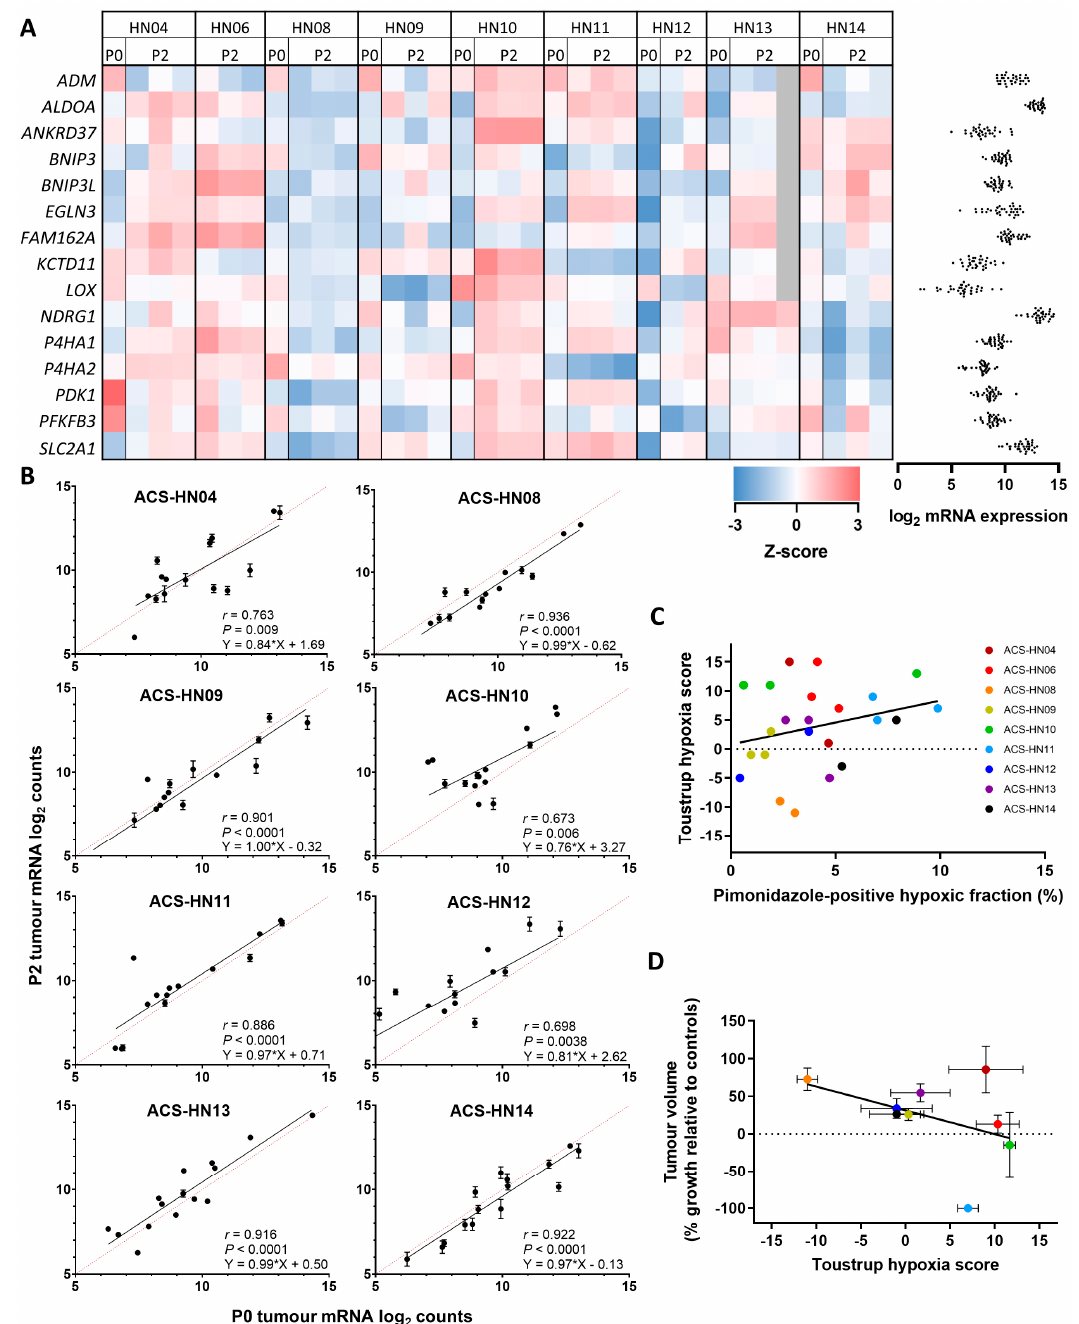
Figure 4. Hypoxia status of HNSCC PDX tumours by Toustrup hypoxia gene signature analysed by NanoString. ( A ) Heatmap of mRNA expression of 15 Toustrup signature genes in P0 and P2 PDX tumours determined as z-score relative to other PDX tumour samples. Red indicates high expression, blue indicates low expression, grey indicates not determined. Gene expression determined as log 2 counts normalised to positive control and three housekeeping genes. Individual counts shown on the right. ( B ) Comparison of mRNA expression of 15 Toustrup genes in P0 ( n = 1) and P2 ( n = 2–3) PDX tumours. Symbols represent mean ± SEM. Dotted lines represent equal expression. ( C ) Comparison of hypoxic fraction assessed by Toustrup hypoxia score and pimonidazole staining. Symbols represent individual tumours. ( D ) Comparison between evofosfamide anticancer efficacy (tumour growth in evofosfamide-treated mice relative to controls at end of treatment or endpoint) and Toustrup hypoxia score. Symbols represent mean ± SEM for n = 2–12 tumours.